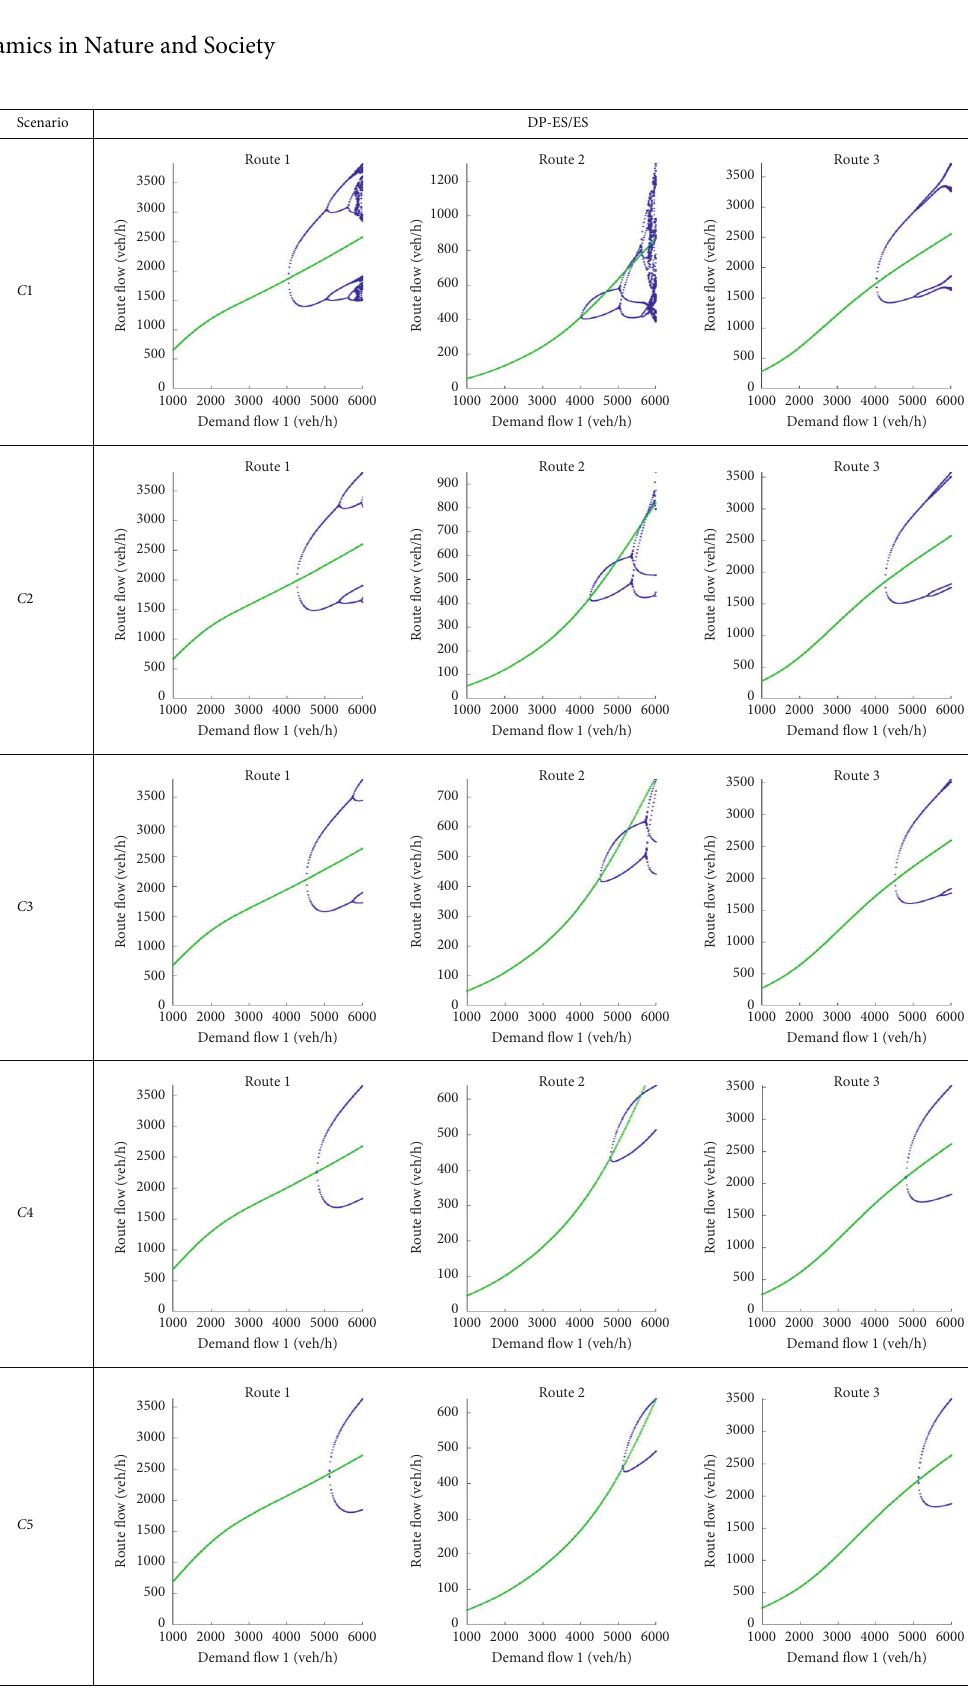
� 7.0 and θ � 4.7; ( η � 0.7 and χ m � TV AV m / μ m )